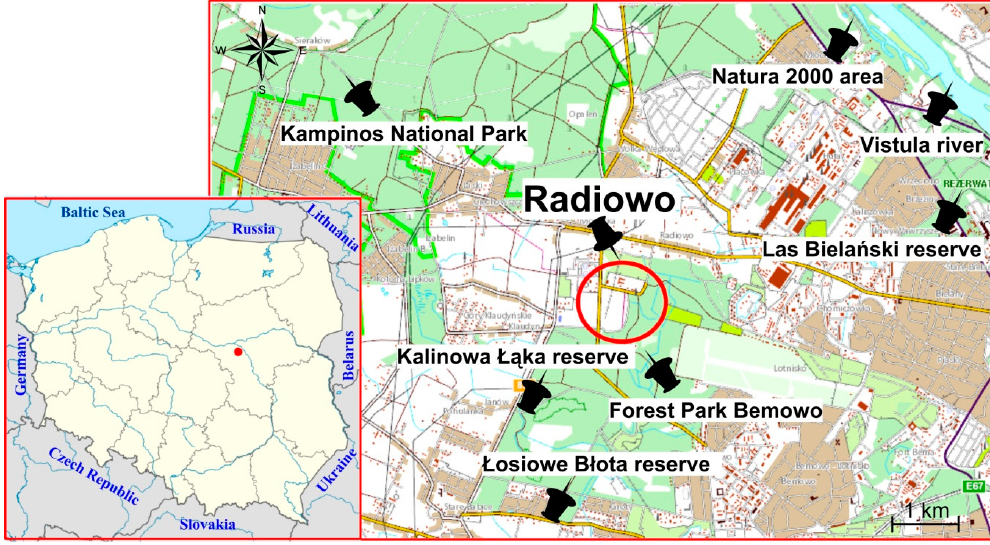
Figure 1. Location of the study area in relation to protected areas.